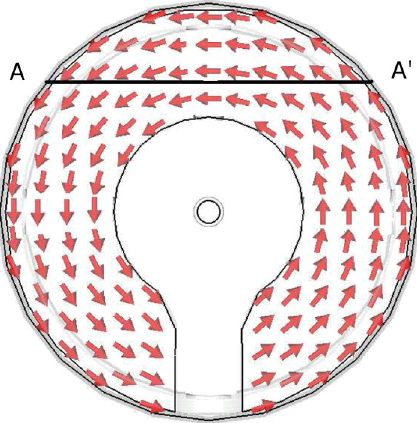
FIG. 21. Schematic view of the magnetic field orientation around the end cell.